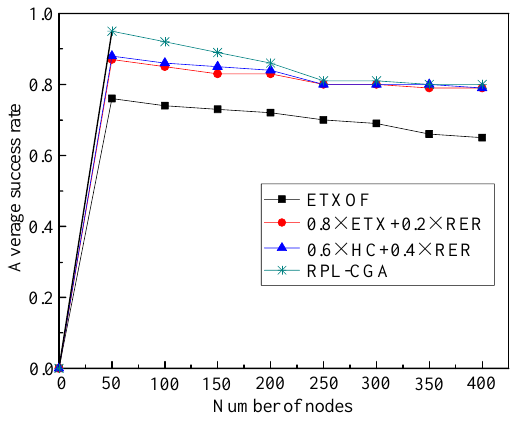
Figure 3. Average success rate.